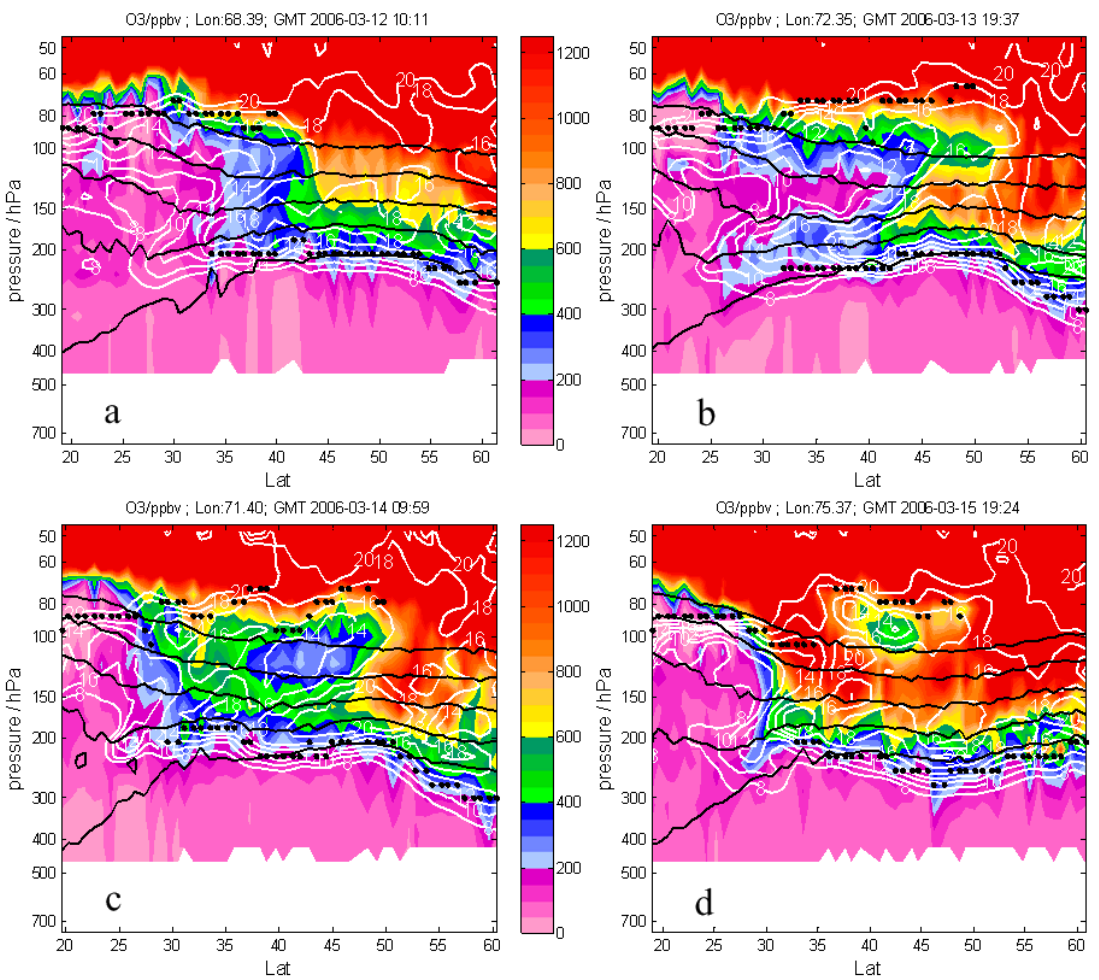
Figure 3. Vertical sections near the RWB along the satellite track on ( a ) 12 March 2006, ( b ) 13 March 2006, ( c ) 14 March 2006 and ( d ) 15 March 2006 of the ozone concentrations from HIRDLS (shaded; unit: ppbv), potential temperature (black contours for 330 K, 350 K, 370 K, 390 K, and 410 K) and its vertical gradients (white contours; unit: K km − 1 ). The black spots represent the positions of the tropopause defined by the temperature lapse rate.